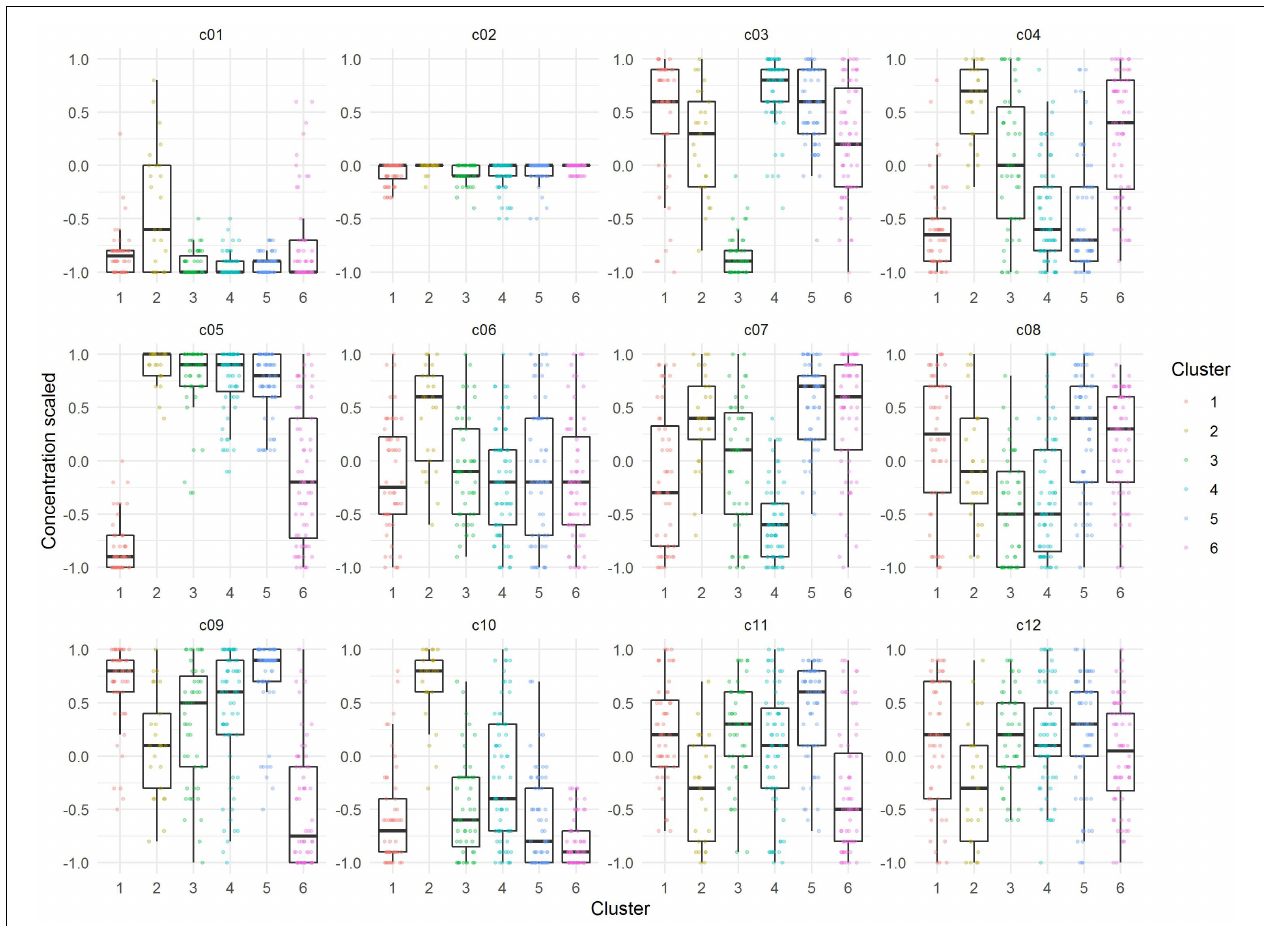
FIGURE 5 | Visualization of relative concentrations of each component in the identified Cluster medium formulations. Dots are representing each individual formulation, while boxes represent the median and spread of the data. concentration of the screened components were selected and used for the confirmation experiment ( Supplementary Table 4